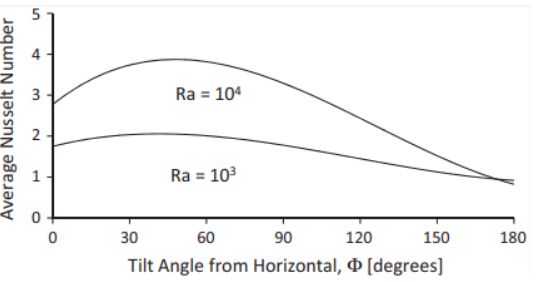
. Reprinted with permission 𝜙𝜙